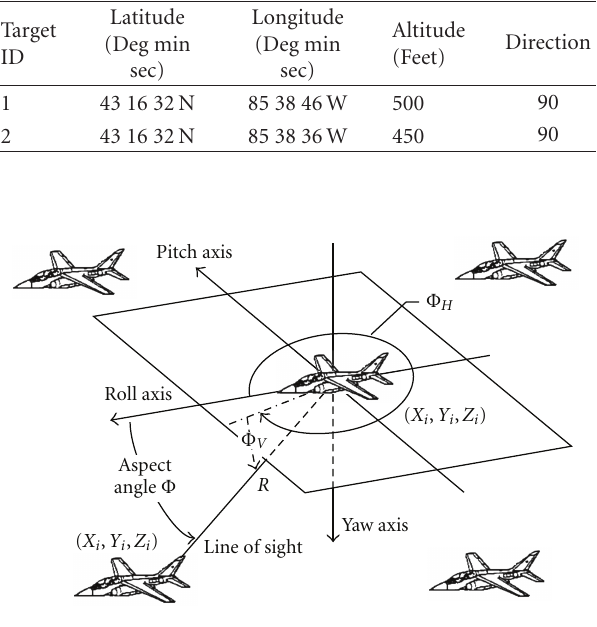
Figure 2: Aspect angle Φ , the angle between the roll and the line of